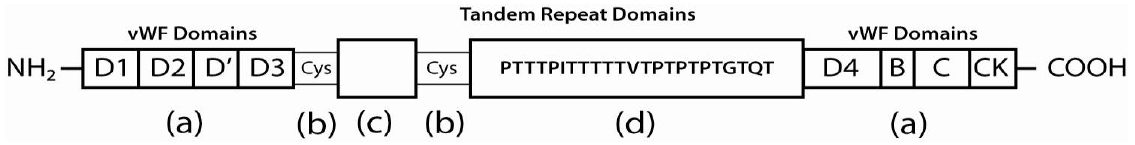
Figure 1. Diagram of the MUC2 protein core. The protein termini contain